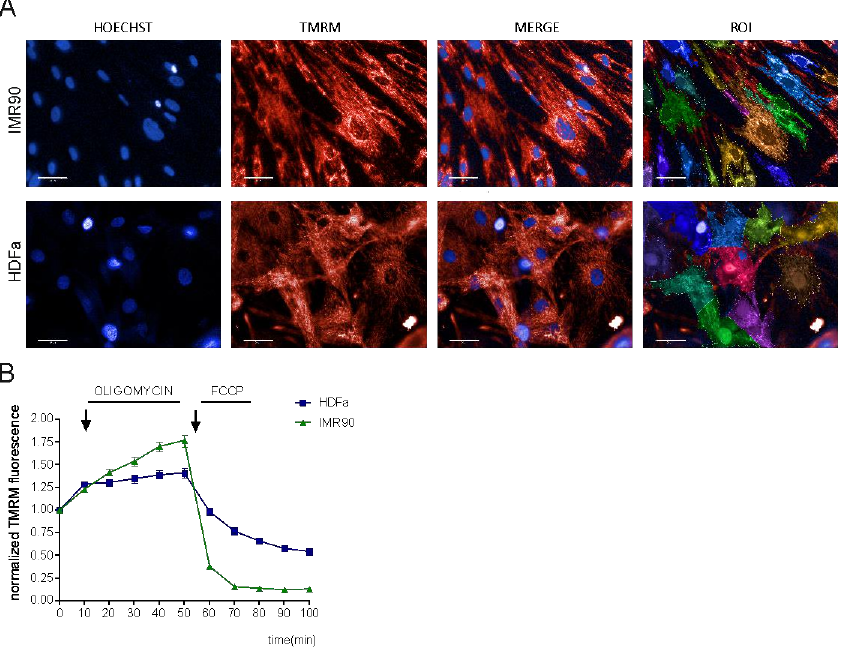
Figure 1. High-content measurement of ∆Ψ m in cell cultures. ( A ) Representative images of primary human fibroblasts (HDFa, IMR-90) stained with TMRM and Hoechst (scale bar 50 µ m). ( B ) Mitochondrial membrane potential ( ∆Ψ m) kinetics of human fibroblasts. To study the changes in ∆Ψ m, the cells were treated with oligomycin and FCCP. Data represent the mean ± SEM of 5–6 biological replicates.